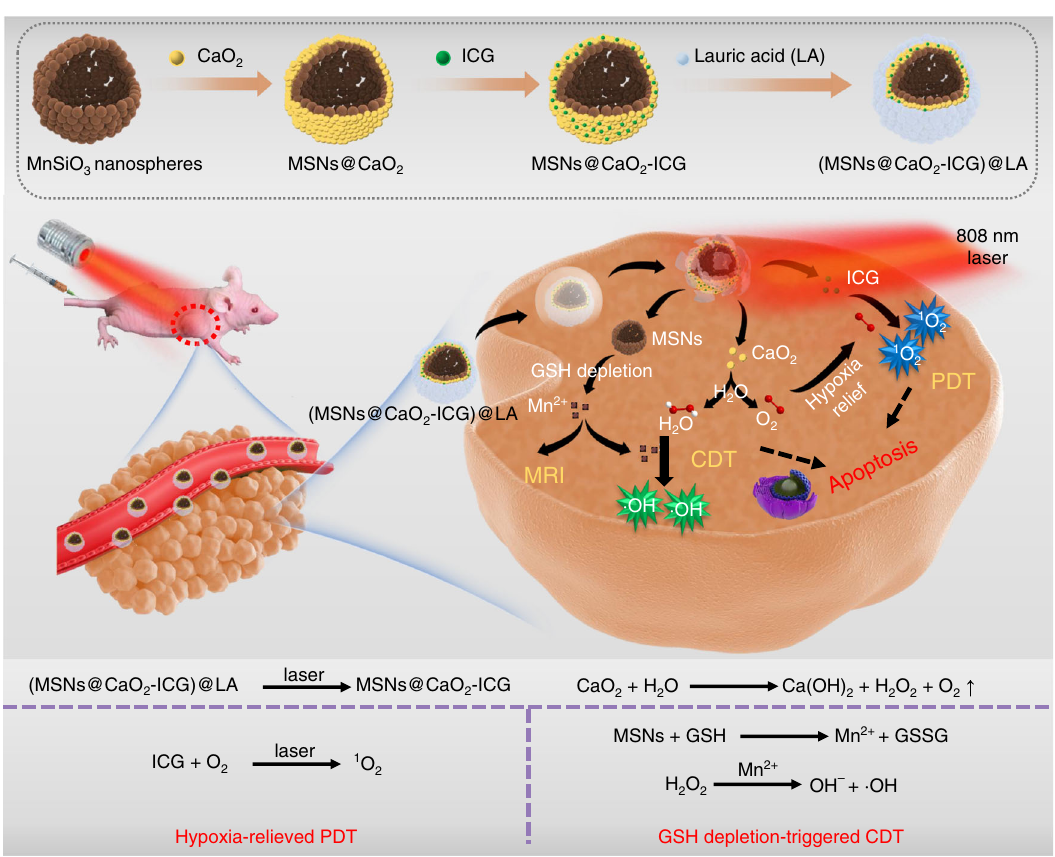
Fig. 1 Open source and reduce expenditure ROS generation strategy. The scheme of fabrication process and therapeutic mechanism of thermo- responsive (MSNs@CaO 2 -ICG)@LA NPs for synergistic CDT/PDT with H 2 O 2 /O 2 self-supply and GSH